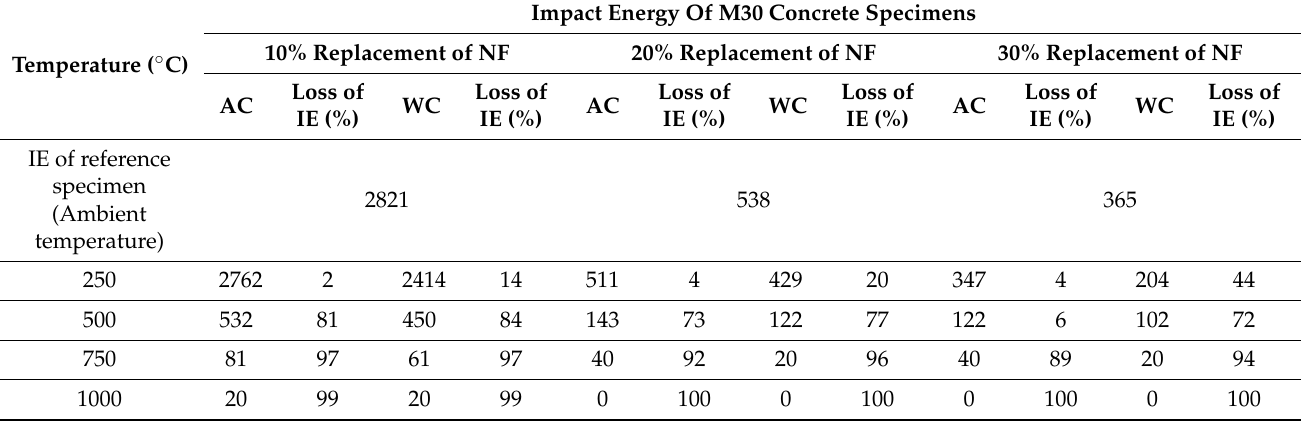
Table 5. The impact energy of specimens cast with